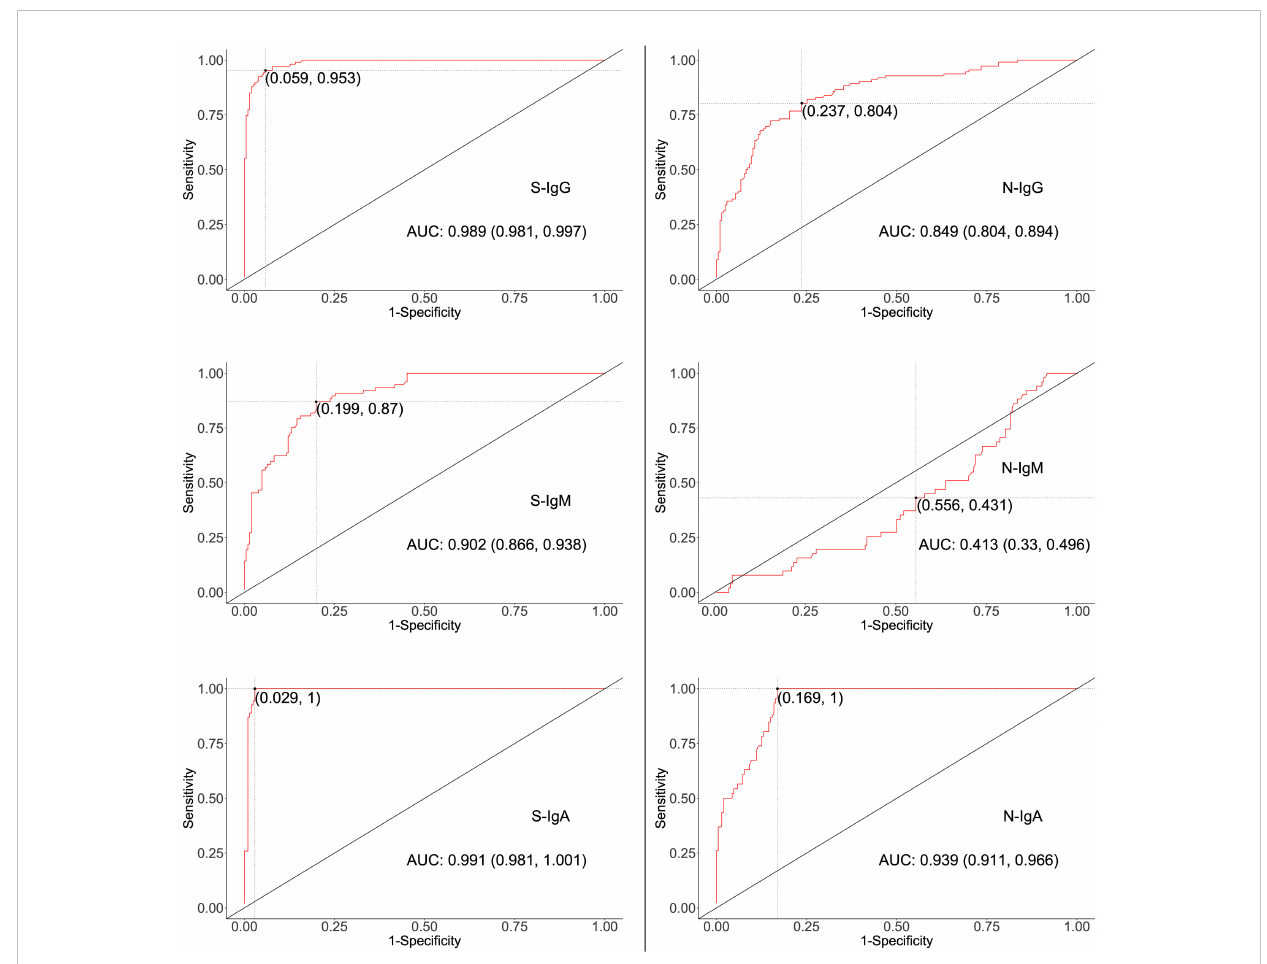
FIGURE 1 ROC curves for determining Cut-offs for spike- and nucleoprotein-directed antibodies. The two-dimensional algorithm ROC graph visualizes how well the test classi fi es subjects as positives or negatives for S- or N-directed IgG, IgM, or IgA antibodies. AUC; Area under the Curve, with 95% Con fi dence